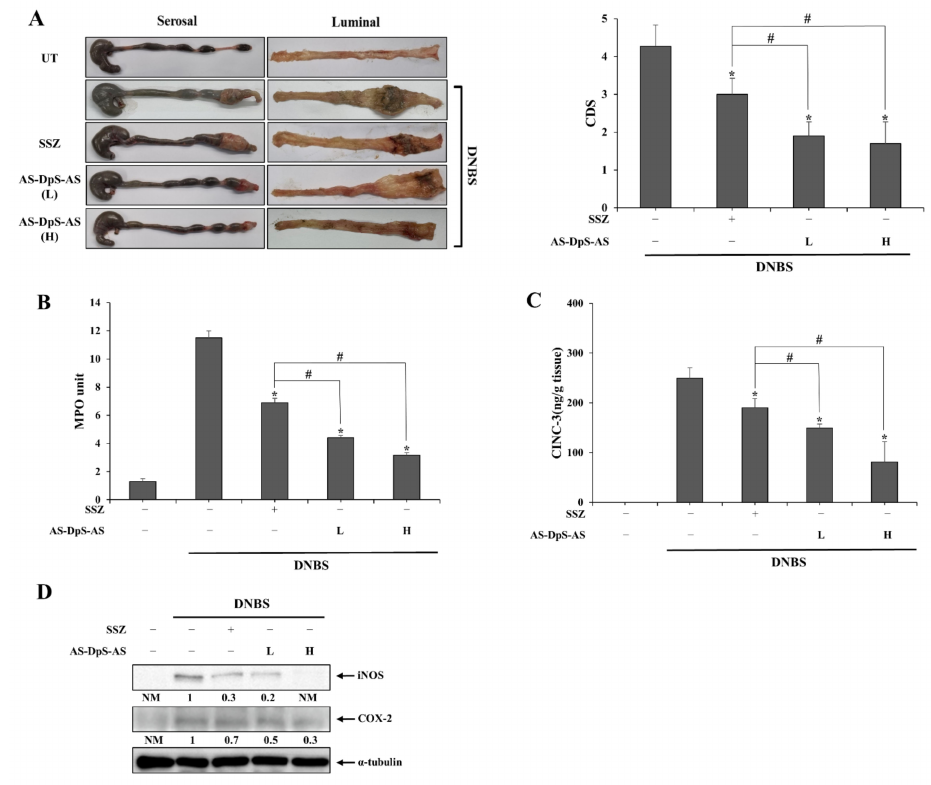
Figure 3. AS-DpS-AS is more effective against DNBS-induced rat colitis than SSZ. Three days after colitis induction by DNBS, SSZ (50 mg/kg) and AS-DpS-AS (L: 17 mg/kg, equivalent to 25 mg/kg of SSZ, H: 34 mg/kg, equivalent to 50 mg/kg of SSZ) were administered orally to rats once per day, and the rats were sacrificed after 6 days of treatment. ( A ) Left panel: Serosal and luminal sides of the distal colon of rats were photographed. Representative images are shown. Right panel: Colon damage score (CDS) was determined for each group, as described in the Section 2. * α < 0.05 vs. DNBS control, # α < 0.05. ( B ) Myeloperoxidase (MPO) activity was measured in the inflamed distal colon (4 cm). * p < 0.05 vs. control, # p < 0.05. ( C ) CINC-3 levels in the inflamed colon were measured using an ELISA kit. ( D ) iNOS and COX-2 levels were measured in the inflamed distal colon using Western blotting. * p < 0.05 vs. control, # p < 0.05. The data in ( A – C ) represent mean ± SD ( n = 5). NM: not